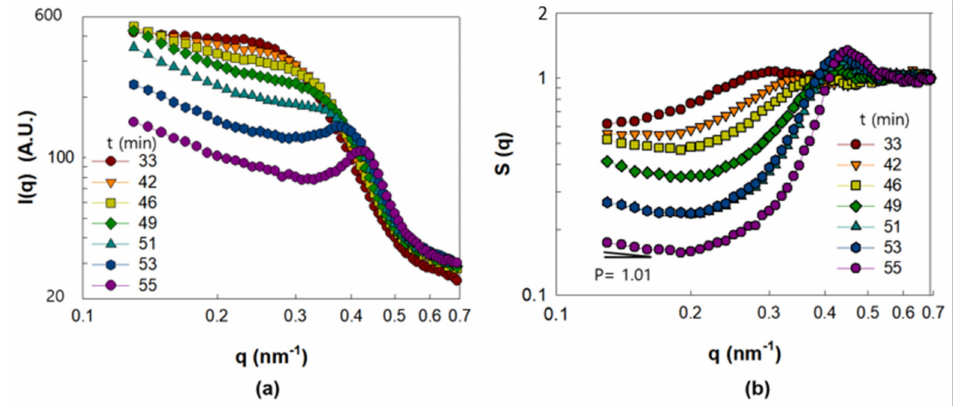
Figure 4. SAXS analysis results of PNC film obtained from Γ 0.03 in the range of drying time from 33 to 55 min. ( a ) I(q) and ( b ) S(q).